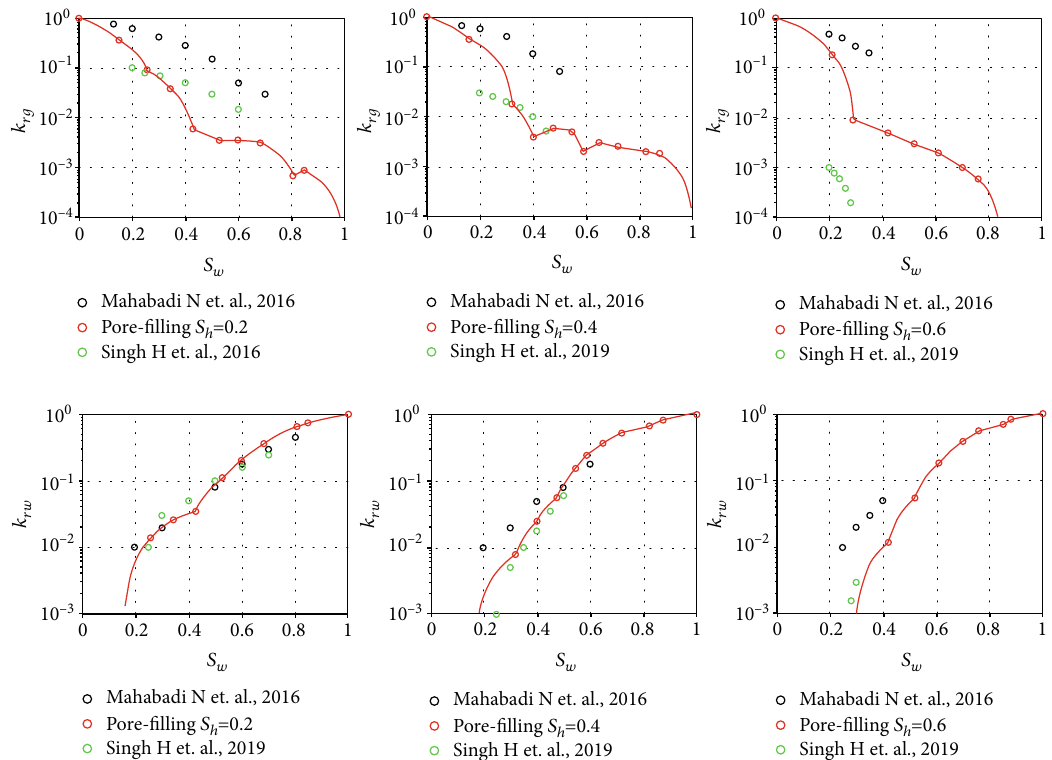
Þ and water ð k Þ as a function of water saturation ð S rg rw